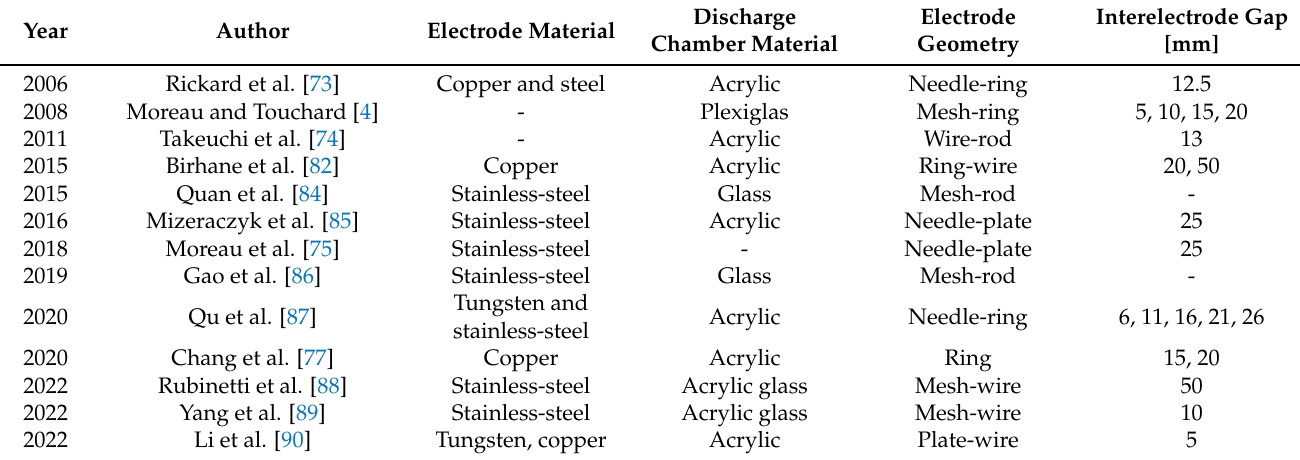
Table 3. Summarized material and geometry of EHD gas pumps in recent